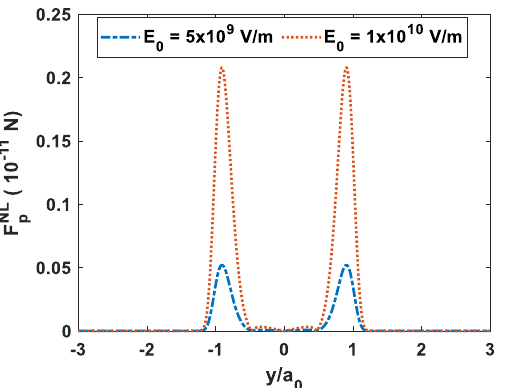
Figure 2. Schematic of the interaction of hat top beams and a medium containing graphite nanocyl- inders with parallel and/or perpendicular orientation of their basal planes.